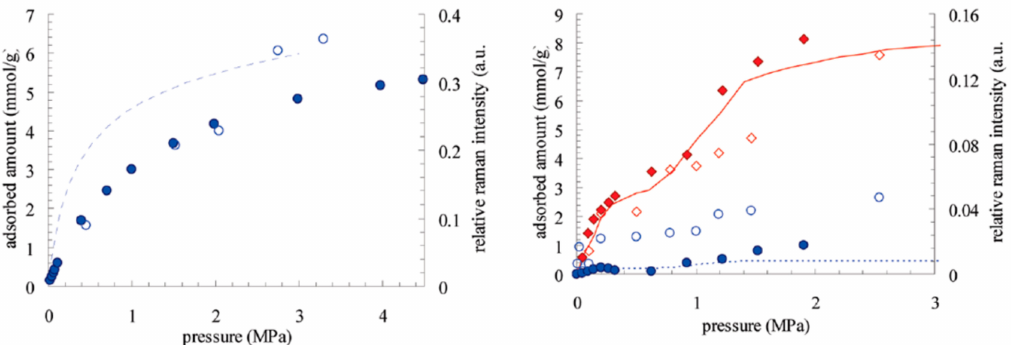
Figure 18. Adsorption isotherms of CO 2 ( (cid:7) ) and CH 4 ( (cid:8) ) on MIL-53(Cr) at 303 K compared to the relative Raman intensity of CO 2 ( ♦ ) and CH 4 ( ). Gas composition CO 2 :CH 4 , left: 0–100 and right: (cid:35) 50–50. The simulation of CO 2 is represented in full line and in dashed for CH 4